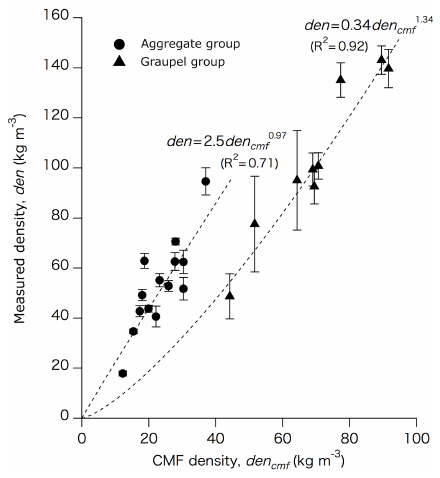
Figure 10. Relationships between the measured density and CMF density for the aggregate (filled circle) and the graupel (filled trian- gle) groups. Dashed lines and equations represent the approximated relationships.